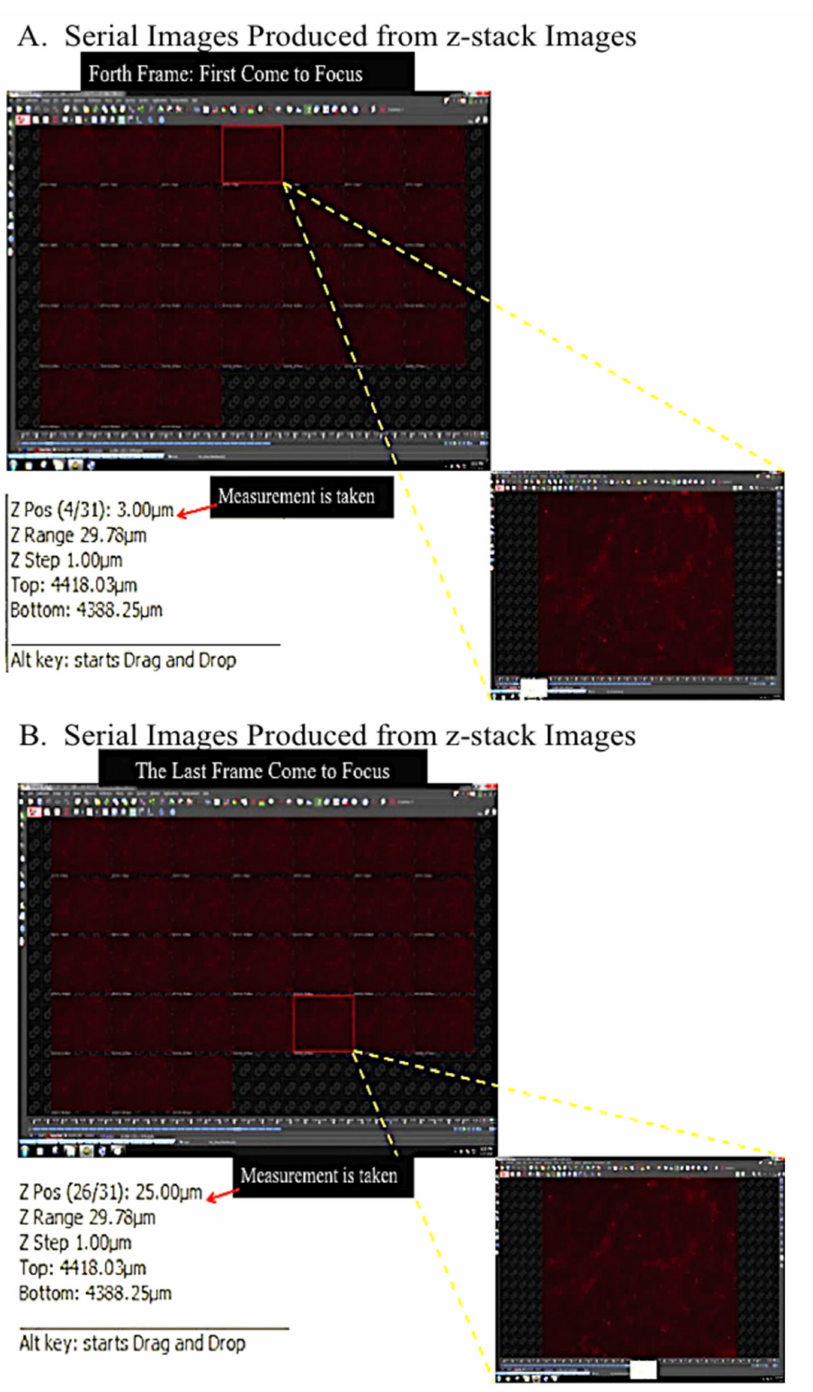
Figure 13. Serial images produced from Z-stack imaging. ( A ) The first and ( B ) the last frame that became in